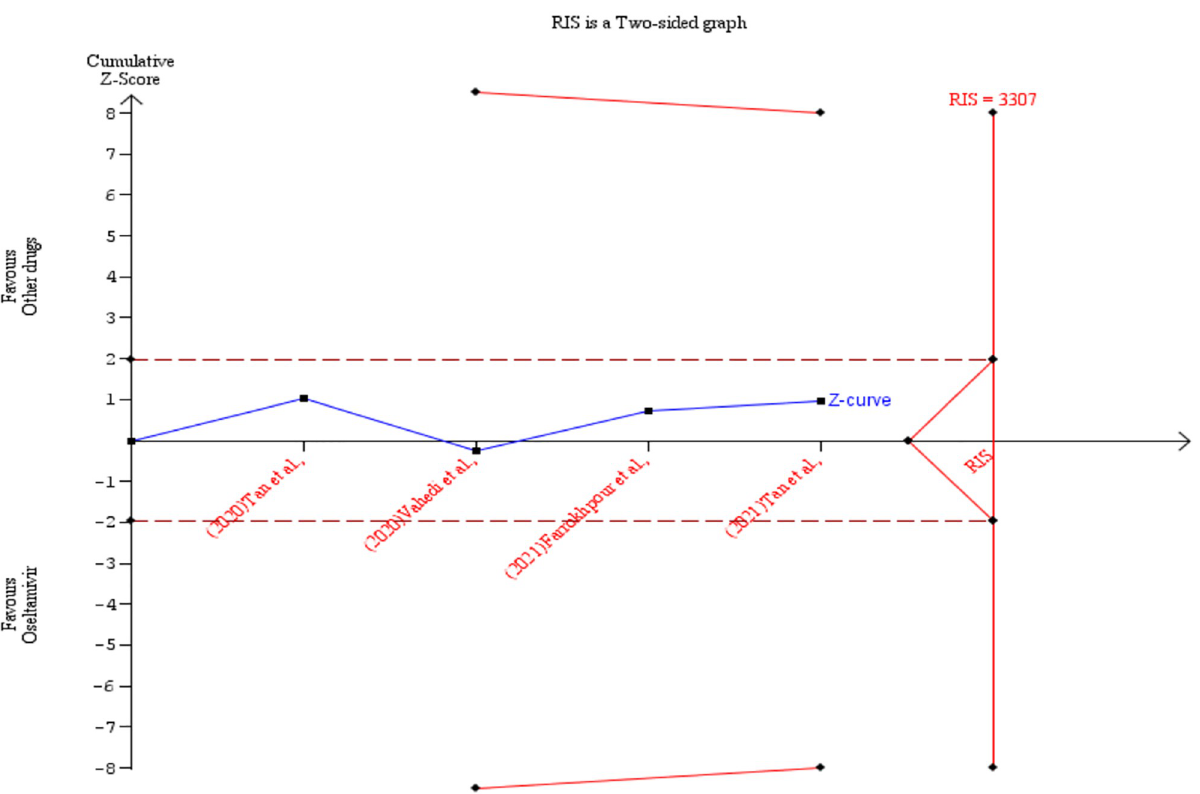
Fig 15. Post-hoc analysis. Shows the trial sequential analysis result comparing the duration of hospitalisation of COVID-19 patients treated with oseltamivir versus other drugs.